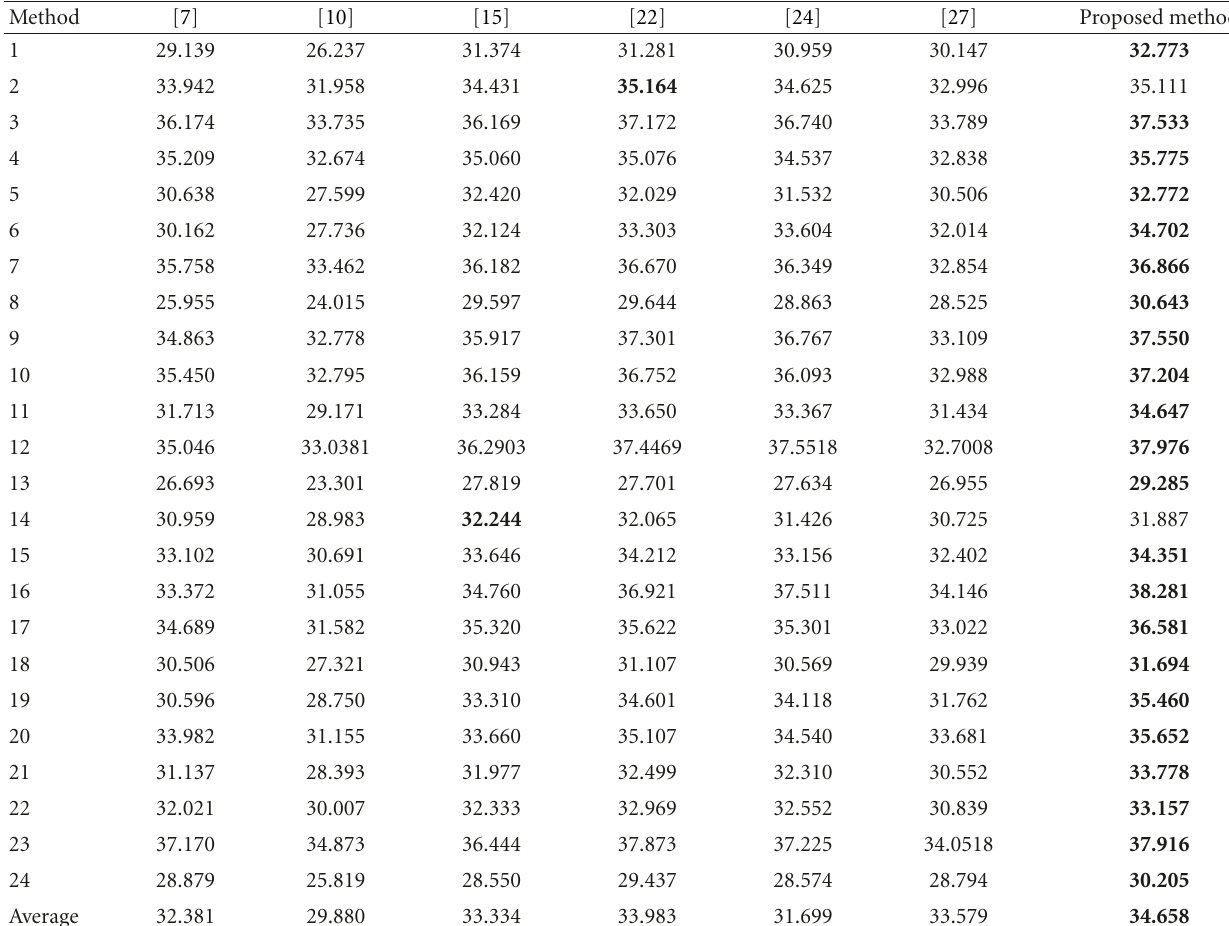
Table 1: PSNR comparison of color demosaicing